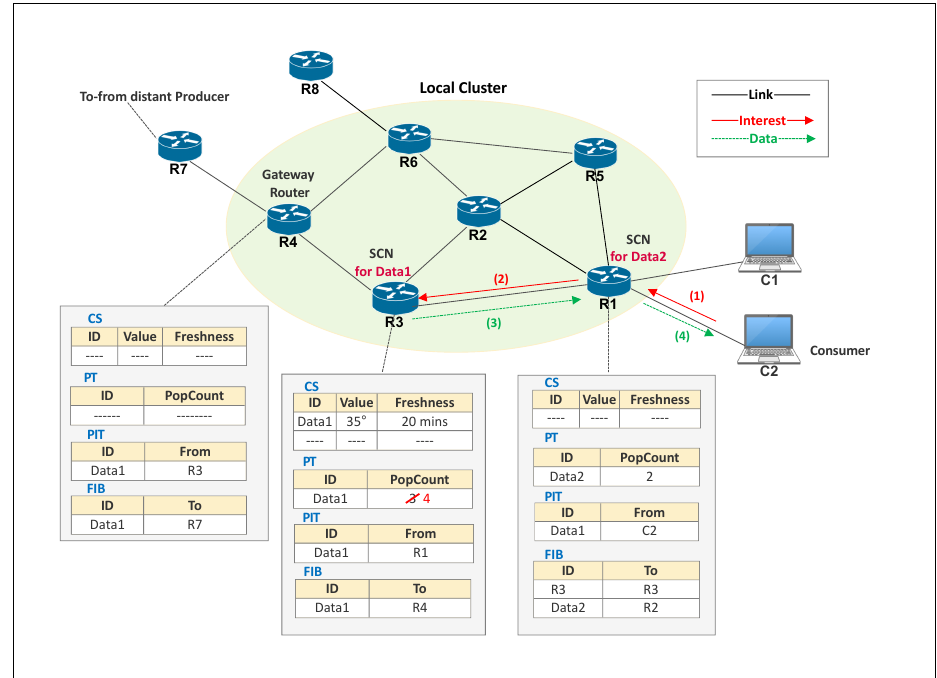
Figure 3. Proposed scheme: Data content already cached at its Surrogate Caching